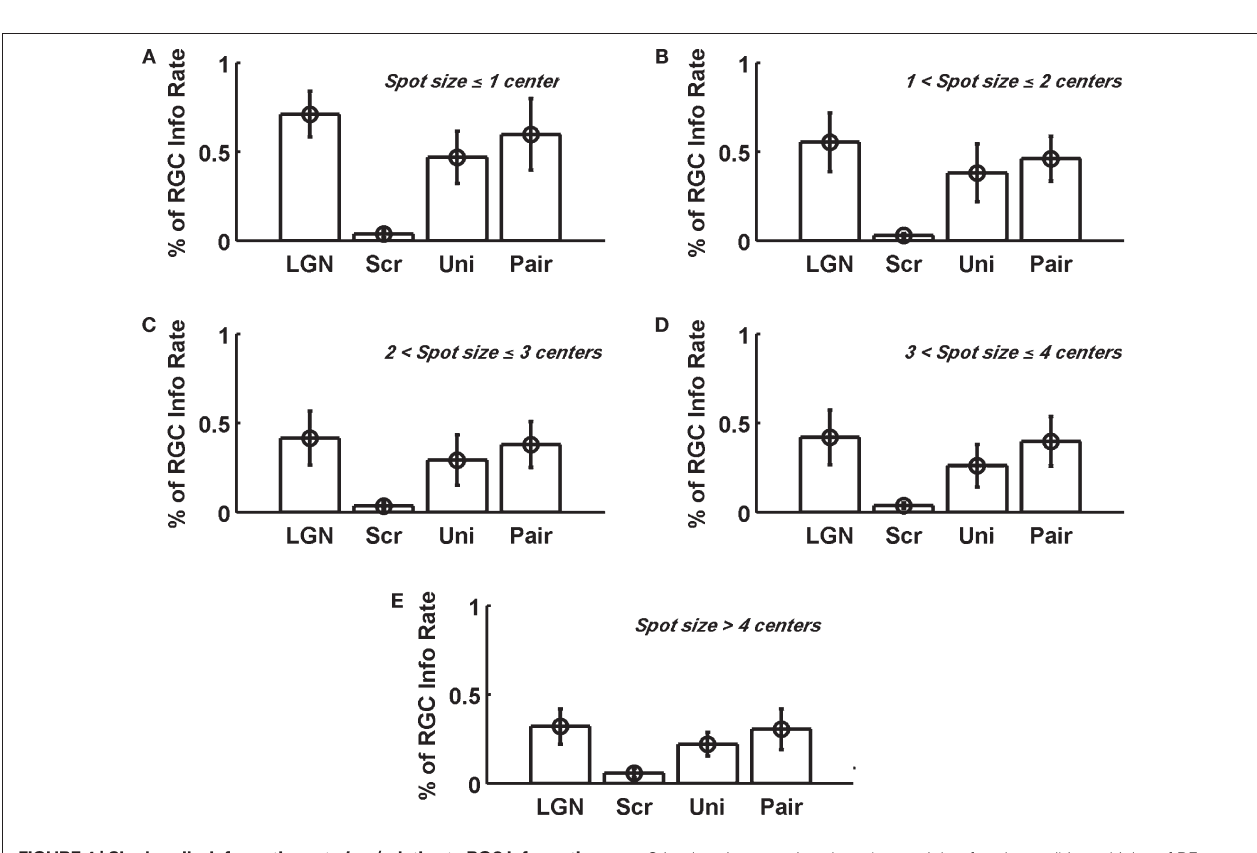
FIGURE 4 | Single spike information rate I (relative to RGC information Stimulus sizes are given here (upper right of each panel) in multiples of RF spike rate) varies with stimulus size. For all the X Off cells, we group the center diameter (see Materials and Methods). ON cells were omitted because results according to stimulus size. For a given group, we compute we did not have enough reliable data from these cells to include them in the average over all the measurements. Error bars are ± 1 SD. this